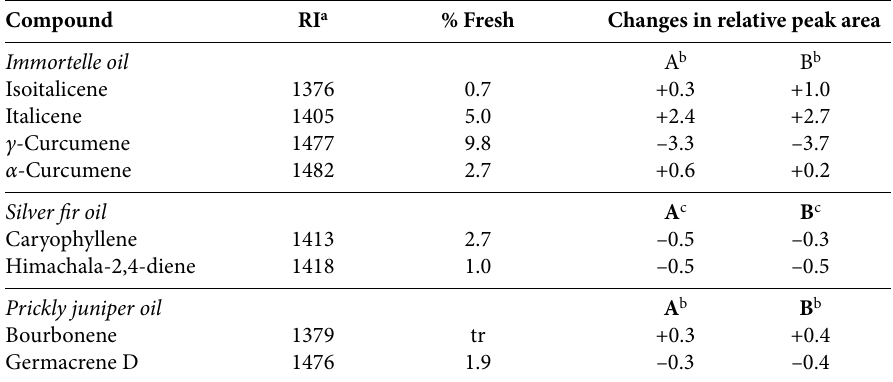
Table 1. Changes in GC-MS relative peak area of characteristic compounds during exposure of essential oils to various conditions